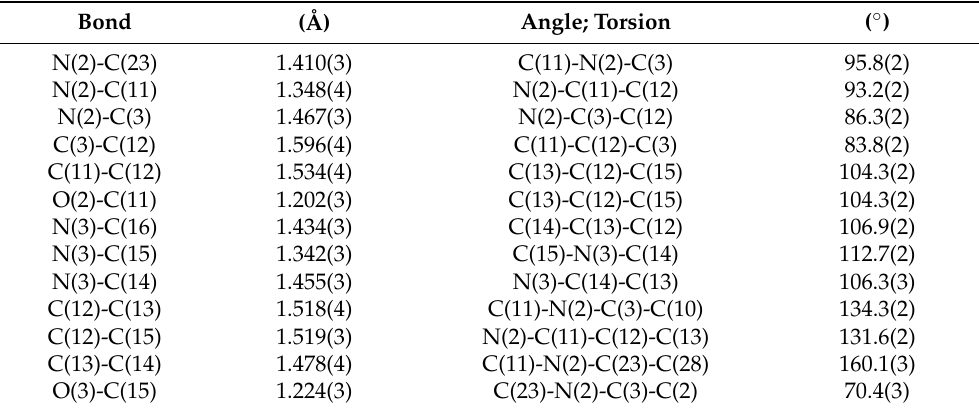
Table 2. Selected bond lengths and angles for compound 5a